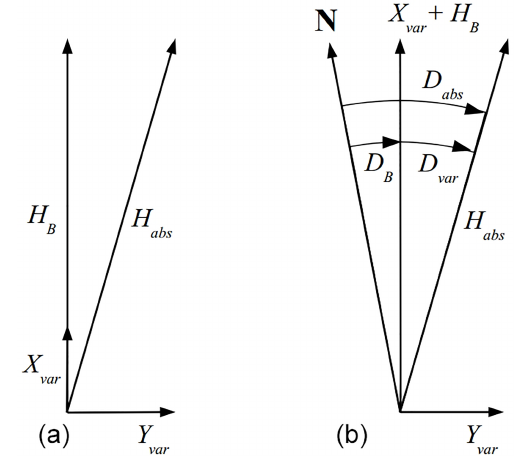
Figure 2. (a) D var and H B + H var form a right-angled triangle with H abs as hypotenuse. (b) The variometer sensor is not per- fectly aligned with the principal geographic directions. Therefore D abs = D B + D var